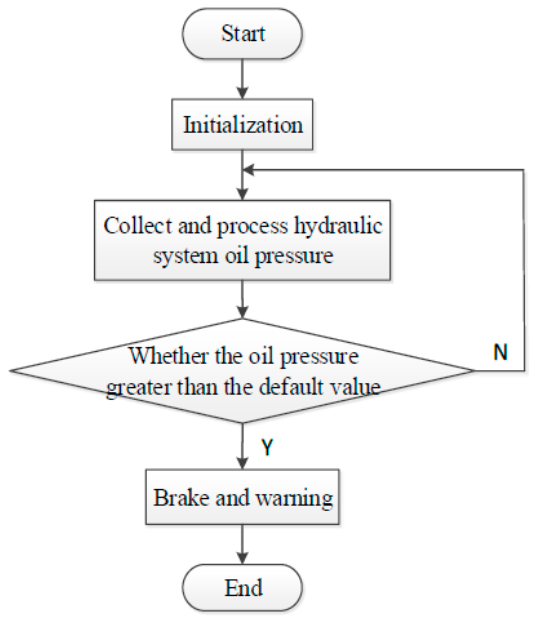
Figure 10. Program flow chart of hydraulic system.